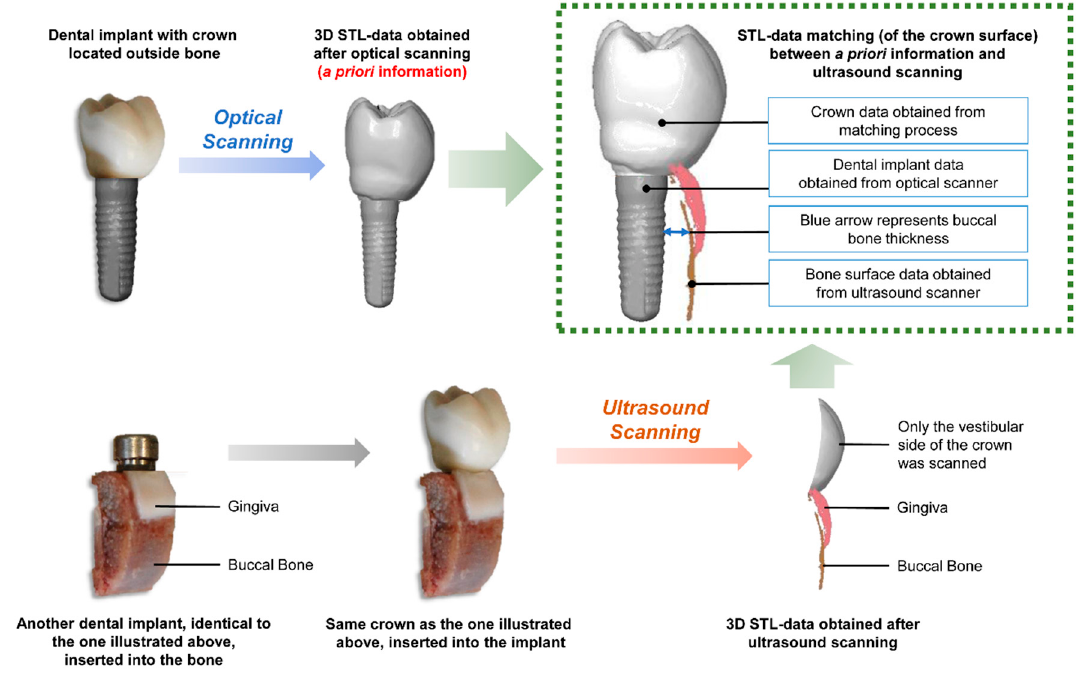
Figure 2. Priori information acquisition and 3D STL-data matching between optical and Figure 2. priori information acquisition and 3D STL-data matching between optical and ultrasound ultrasound scanning.